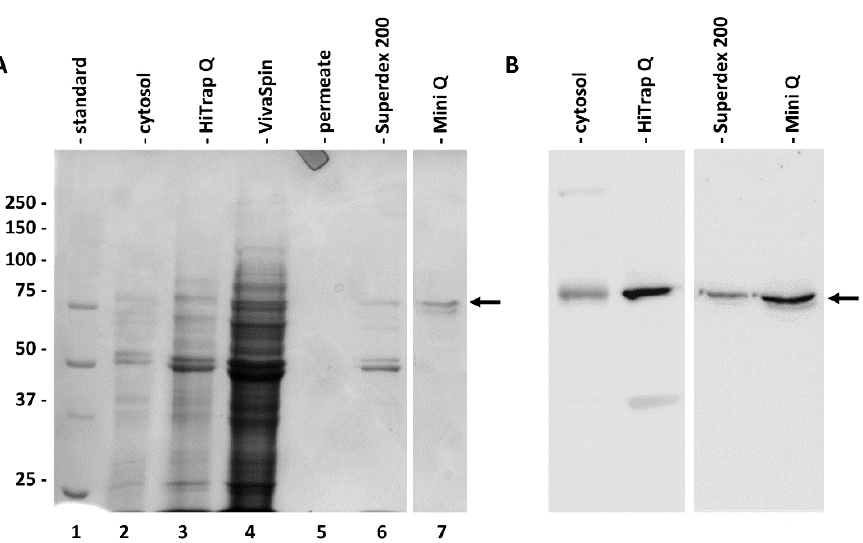
Figure 3. Electrophoretic summary of the purification of Sucrose synthase . ( A ) Gels electrophoresis of the main fractions obtained during purification. Lane 1, molecular weight standard whose value in kD is shown on the left; lane 2, cytosol fraction; lane 3, pool after anion exchange chromatography with a HiTrap-Q column; lane 4, the same sample after concentration with a VivaSpin; lane 5, the permeate; lane 6, pool after gel filtration chromatography with a Superdex 200 column; lane 7, pool after anion exchange chromatography with a Mini-Q column. The arrow on the right indicates the position of the purified band. ( B ) Western blot analysis with the anti-sus-1 antibody on some fractions shown in A, particularly the cytosol fraction, as well as the pool after HiTrap-Q and the pools after Superdex 200 and Mini-Q chromatography. The arrow on the right indicates the position of the cross-reactive band.